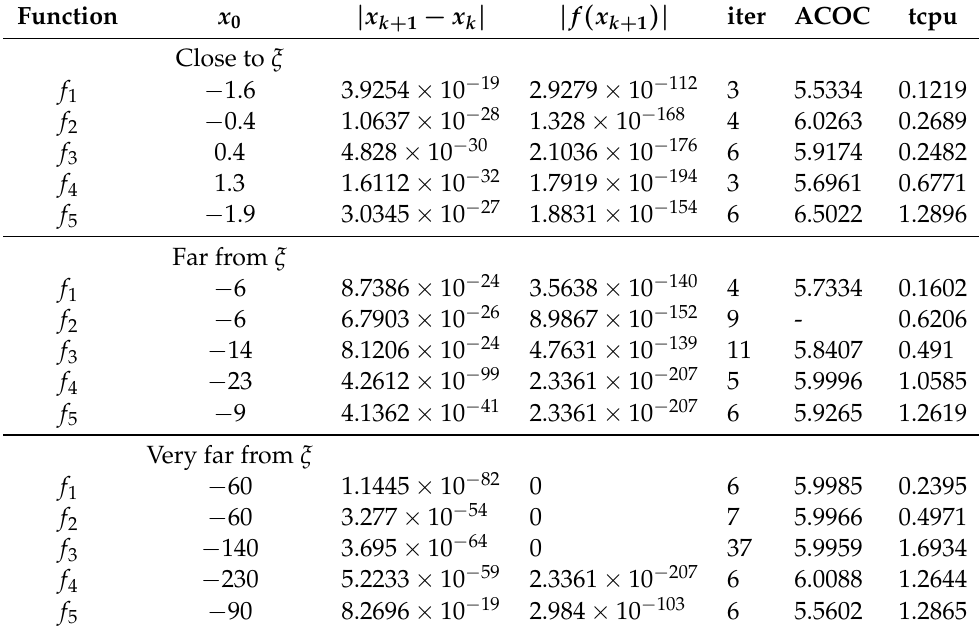
Table 5. Numerical performance of CMT (0) method in nonlinear